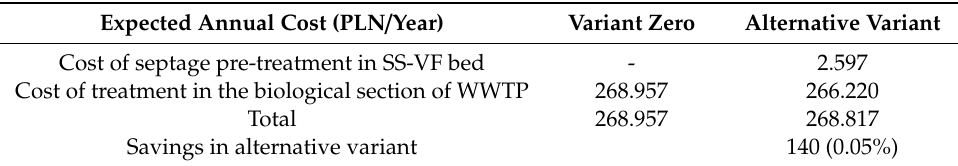
Table 3. Example 3—comparison of costs in variant zero and in alternative variant.